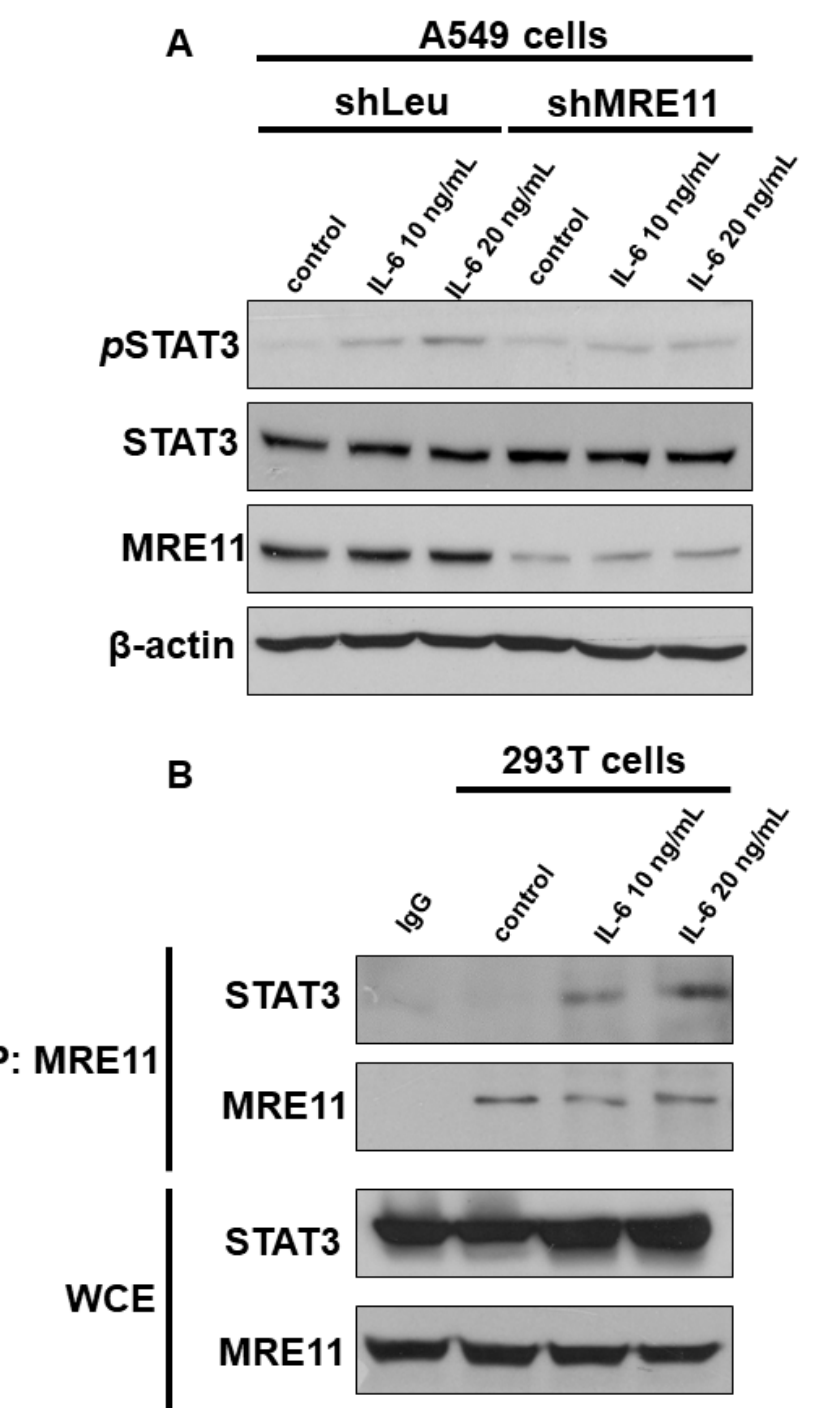
Figure 1. The effect of MRE11 on the protein expression of p -STAT3 and interaction with STAT3. ( A ) Total cell extracts of A549 shLeu and A549 shMRE11 cells were harvested from cells treated with IL-6 for 24 h. A549 cells silenced with MRE11 were treated with indicated concentrations of IL-6 for 24 h. The protein was immunoblotted with polyclonal antibodies specific for p -STAT3, STAT3, or MRE11. β -actin was used as an internal loading control. ( B ) After treatment with indicated concentrations of IL-6 for 24 h, 293T cells were harvested for immunoprecipitation with MRE11 antibody, followed by Western blotting analysis.